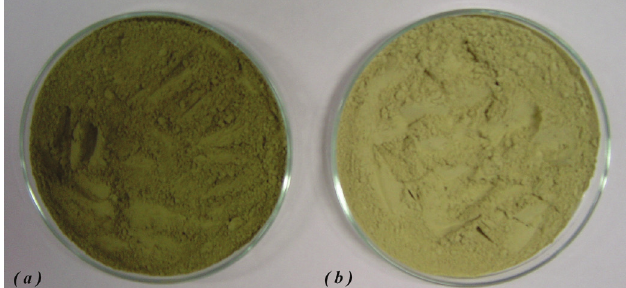
FIGURE 3 - Colour characteristics of the dried extracts (a: spouted bed dried extract, b: spray dried